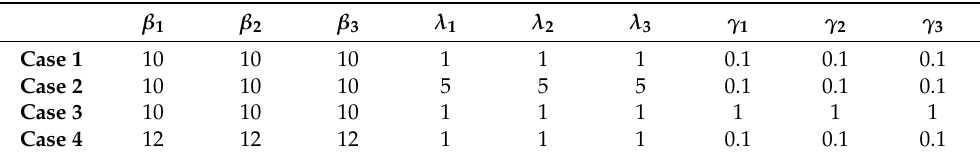
Table 2. The control parameters of the inner loop.